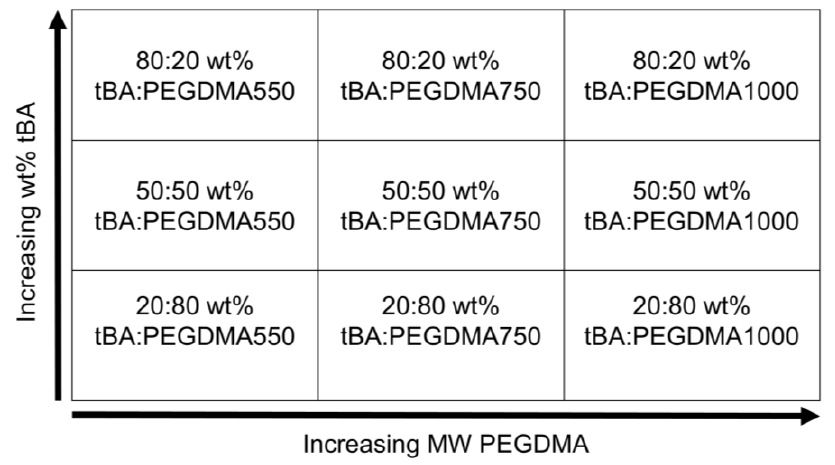
Figure 1. Shape Memory Polymers (SMP) formulation matrix of the nine formulations used.